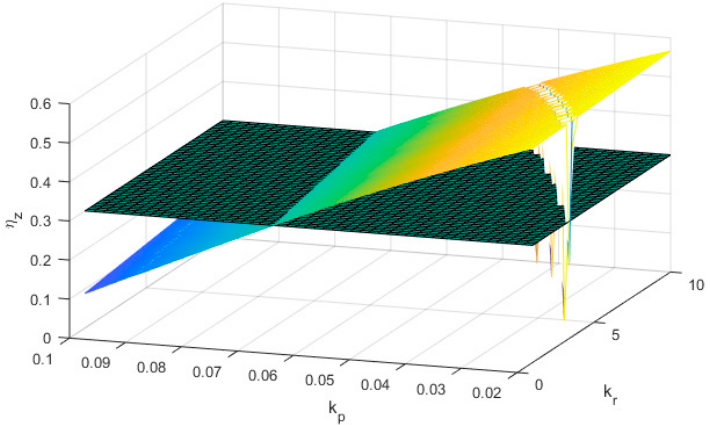
Figure 12. Minimum distance to the critical point of the Nyquist trajectory of Z g ( s )/ Z inv ( s ) with PMR control; color indicates the values of η z .